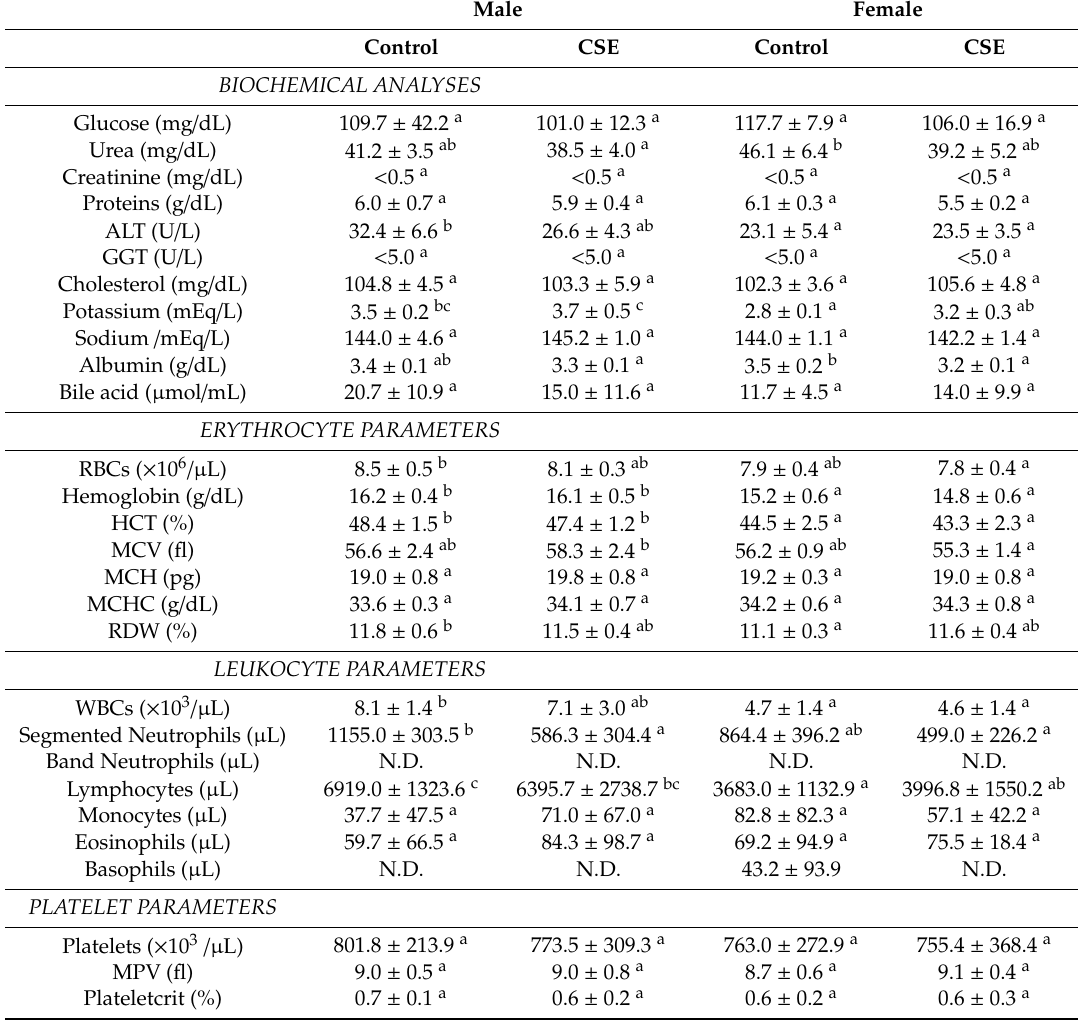
Table 4. Clinical biochemistry and hematology of blood samples from control rats ( n = 15) and rats treated with CSE (1 g / kg) ( n =